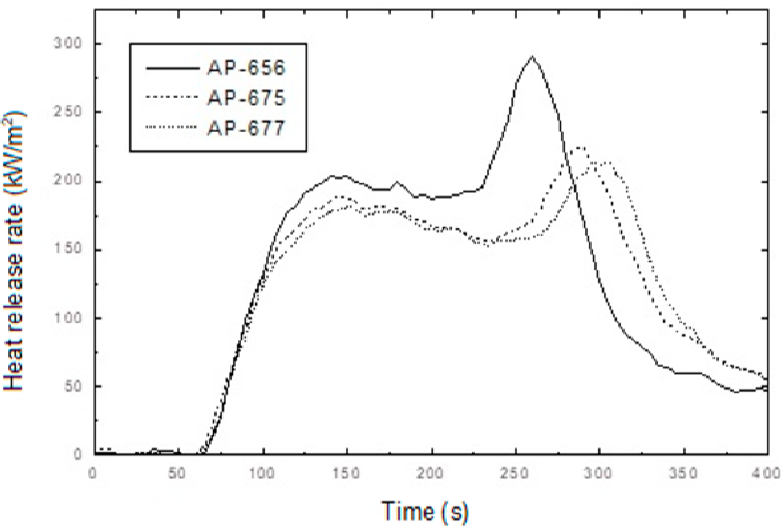
Figure 9. Relationships between LOI and PHRR in RP content formulations. RP content: AP ‐ 656 = 0, AP ‐ 675 = 3 phr and AP ‐ 677 = 5 phr.